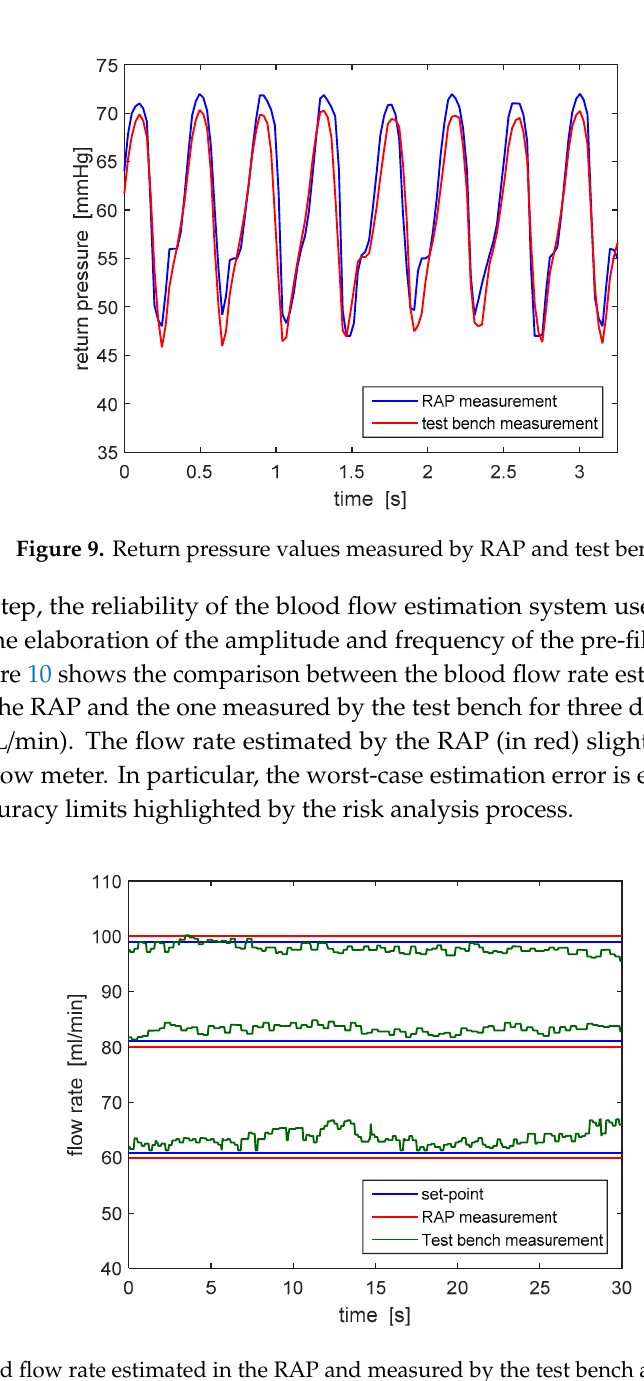
Figure 11. Comparison of temperature values read by the RAP and the test bench.